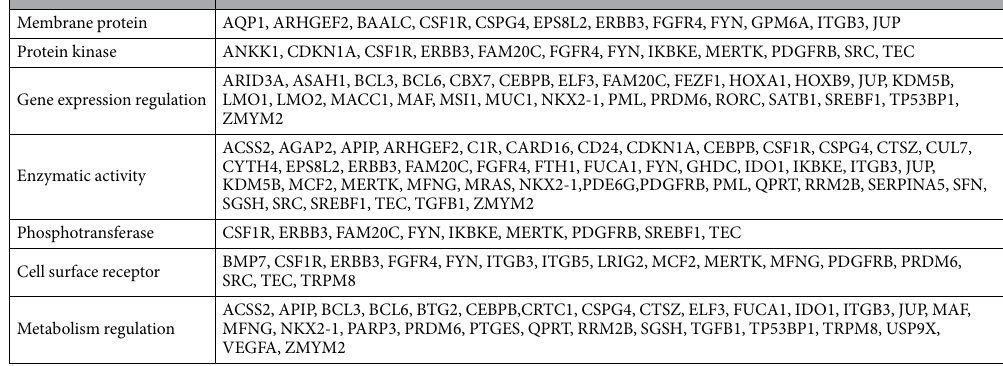
Table 1. List of oncogenic factors, genes whose high expression is associated with poor survival and genes previously associated with radio-resistance in GBM that showed increased expression upon radiation. Genes are listed according to molecular